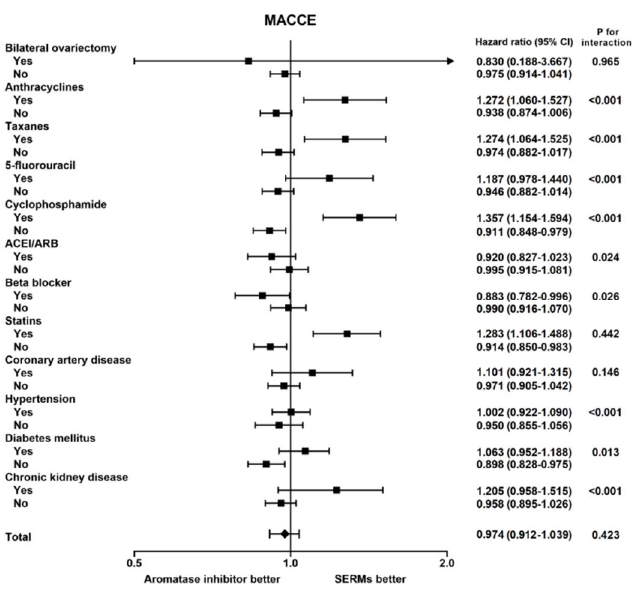
Figure 2. The subgroup analysis of risks of major adverse cardio-cerebral events (MACCEs) in breast cancer patients receiving either selective estrogen receptor modulators (SERMs) or Aromatase inhibitors (AIs) in the nationwide cohort.